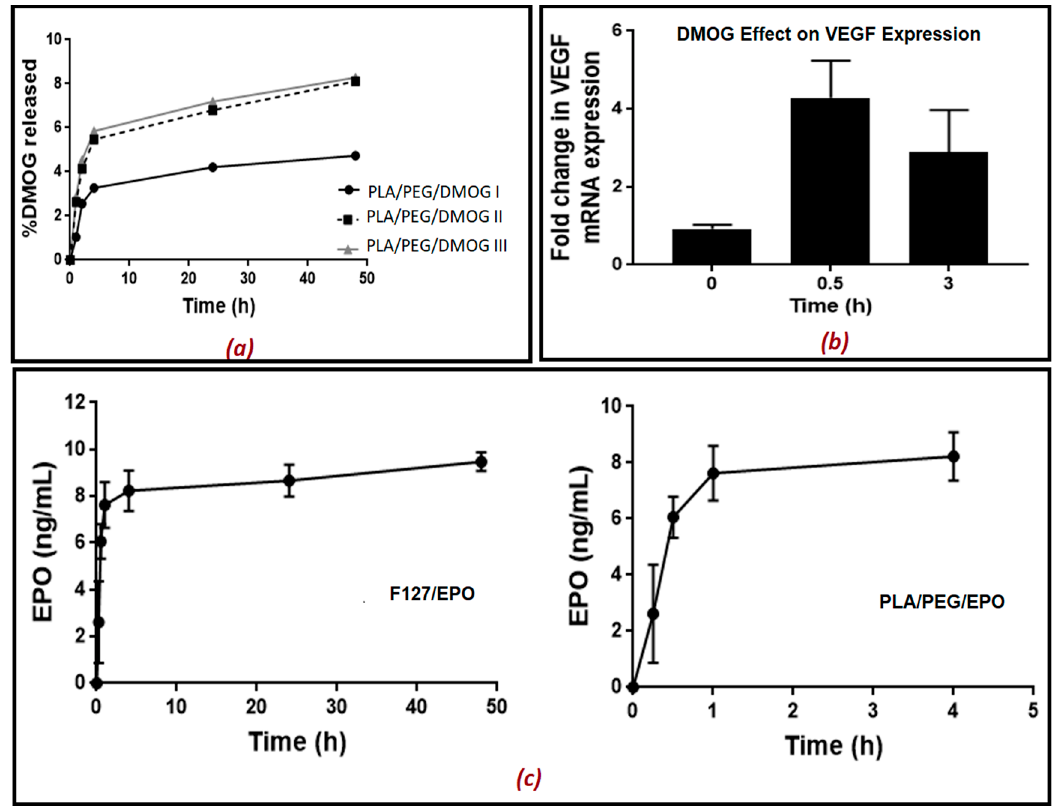
Figure 7. The release of HIF-1 α inducer; ( a ) DMOG from 3D printed scaffolds in phosphate buffered saline solution (PBS) at room temperature. DMOG was used at a concentration of 30% in all the matrices prepared. (The biomaterial mixture contained PLA/PEG in the ratio 70:0, 60:10 and 50:20), ( b ) Fold change in VEGF gene expression in cell lysates after treating rat aortic endothelial cells with different samples of DMOG released at different time points (0, 0.5 and 3 h), and VEGF gene expression VEGF mRNA levels were measured as arbitrary units versus the untreated samples. ( c ) release of EPO from the 3D printed scaffolds. Data are the mean ± SEM of 6 samples. P** < 0.01 [ P** denotes very significant].